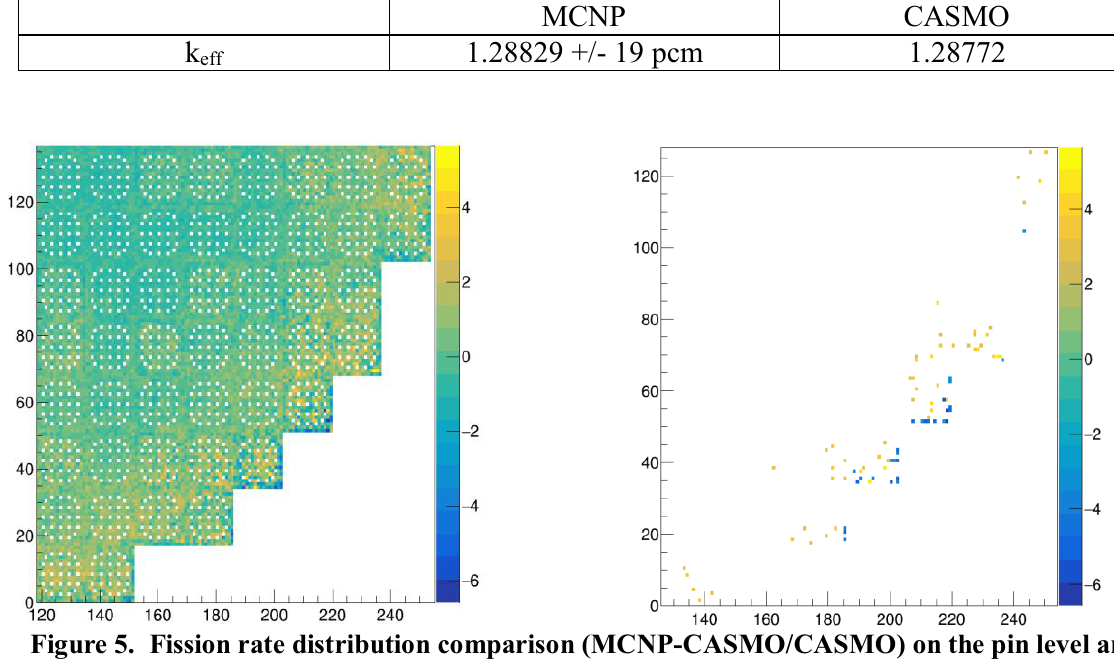
Figure 5. Fission rate distribution comparison (MCNP-CASMO/CASMO) on the pin level and filtering the discrepancies above 3% for a hybrid UOX/MOX core loading.